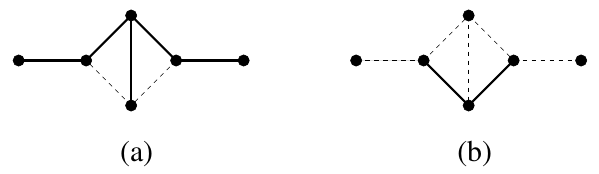
Fig. 2: The two possible colorings of a halter (Bold edges are colored 1 and dashed edges are colored 2